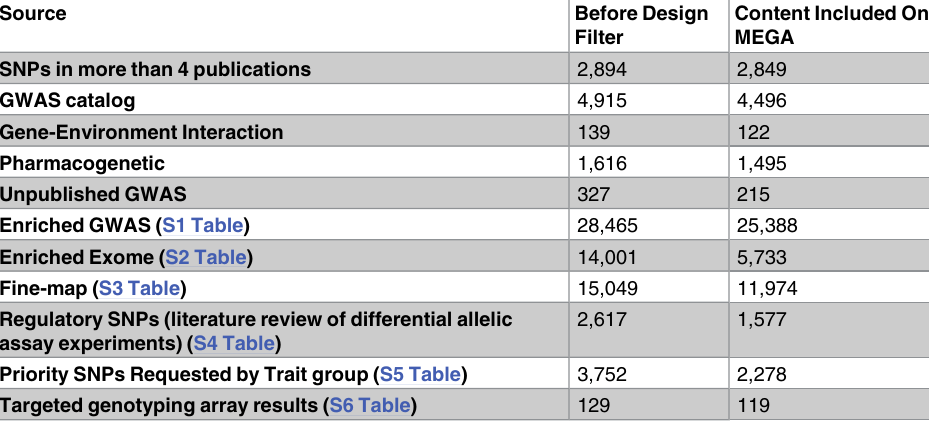
Table 3. Custom Content Variants Before and After Design.